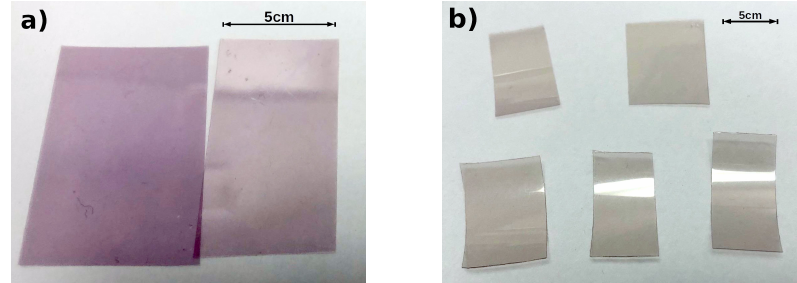
Figure 1. Pictures of Bayfol ® HX200 film samples for ( a ) unrecorded/unexposed and ( b ) cured